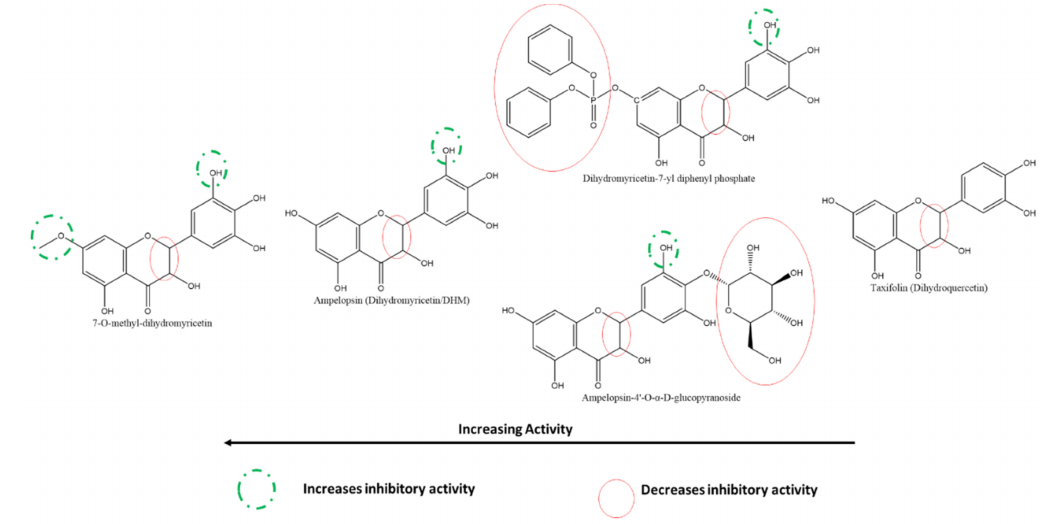
Figure 11. Structure–activity relationships of various flavanonols against SARS-CoV-2 3CLpro, adapted from the in vitro experiments of [117,118]. Substitutions and groups that result in increase/decrease in inhibitory activities are shown in red and green,